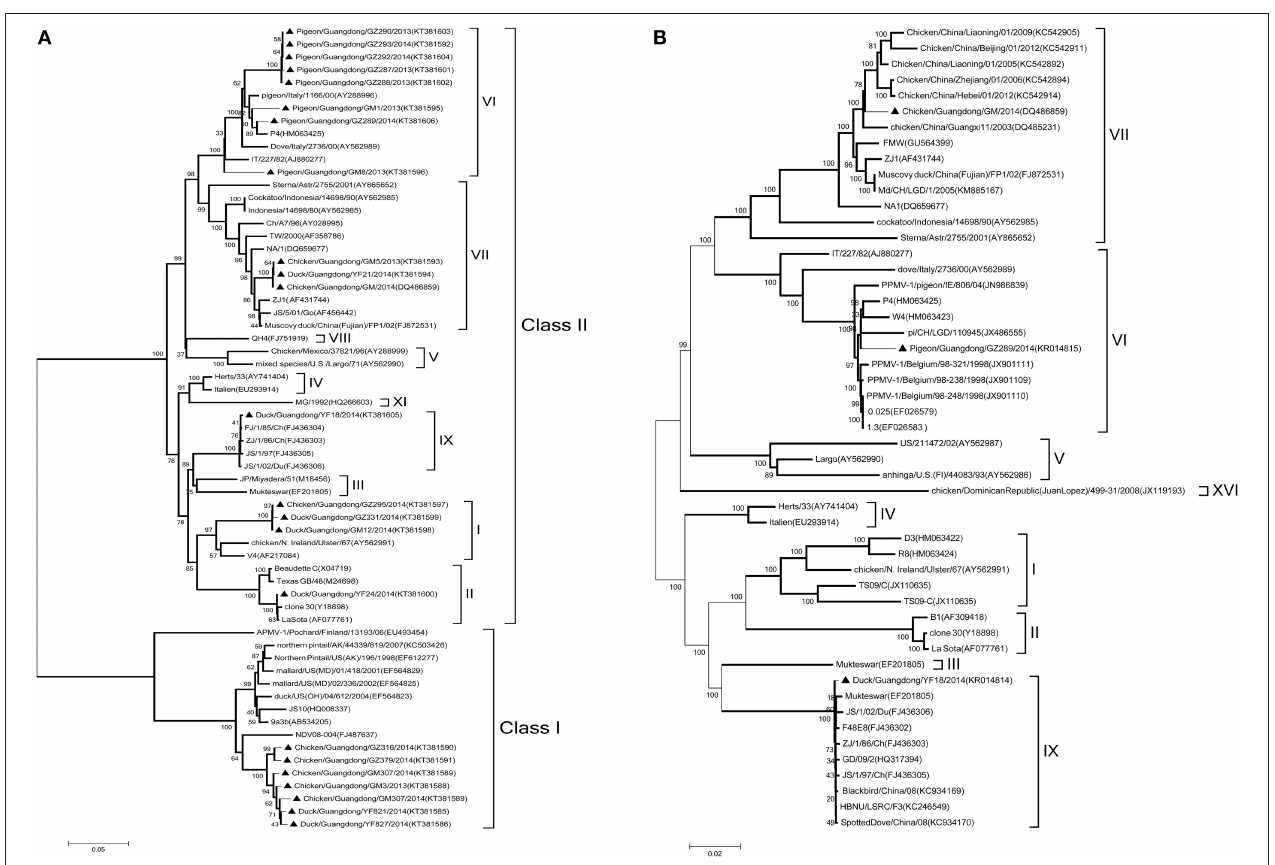
FIGURE 1 | Phylogenetic tree of NDV strains. (A) Phylogenetic analysis based on the F-gene open reading frame (1662 nt) of viruses representing NDV class I and II available in Gen Bank. (B) Phylogenetic analysis based on the complete genome sequence (15192nt) of the GM, YF18, and GZ289 strains derived from different birds. Viruses highlighted with the black triangles ( N ) were characterized in this study. The tree was constructed using the Maximum Likelihood method with the Generalized Time Reversible GTR+G+I4 model of software MEGA (version 5.02), with 1000 bootstrap trials to assign confidence to the